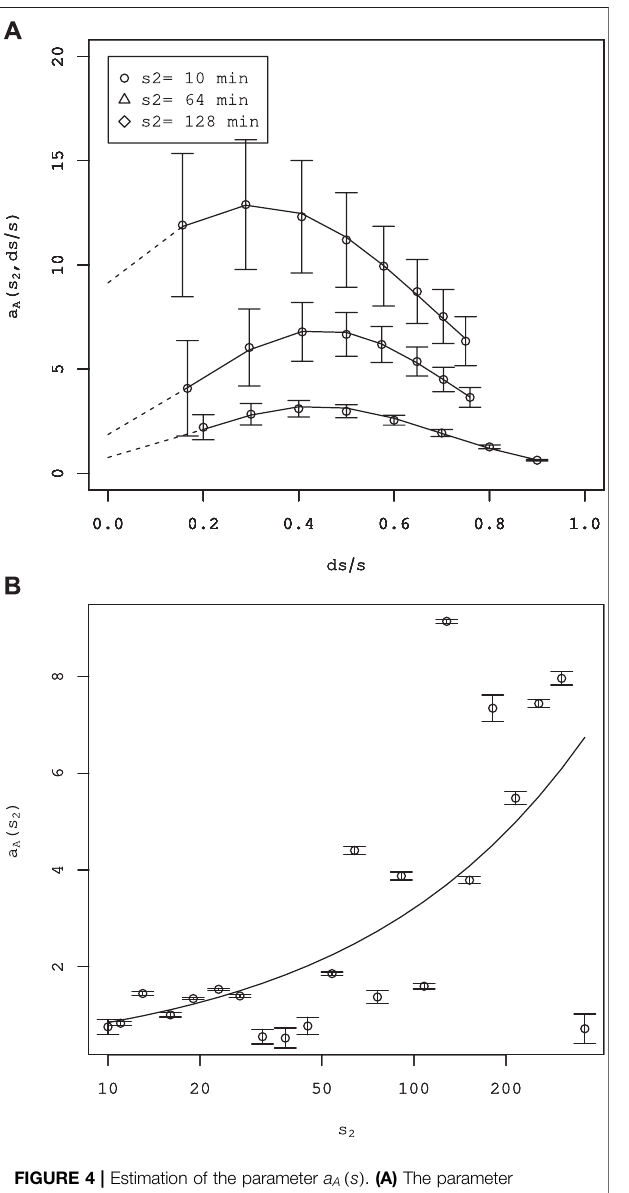
( s , ds / s ) and nonlinear Figure 7A presents examples of b 2 2 A ( s , ds / s )) (cid:2) a + b ( ds / s ) + c ( ds /s ) 2 . fi tting by the function log ( b 2 A ( s ) for each line by b 2 ( s ) (cid:2) exp ( a ) . The result is We estimate b 2 A A presented in Figure 7B . The solid line is the least-squares fi t b 2 to a power law function as follows: